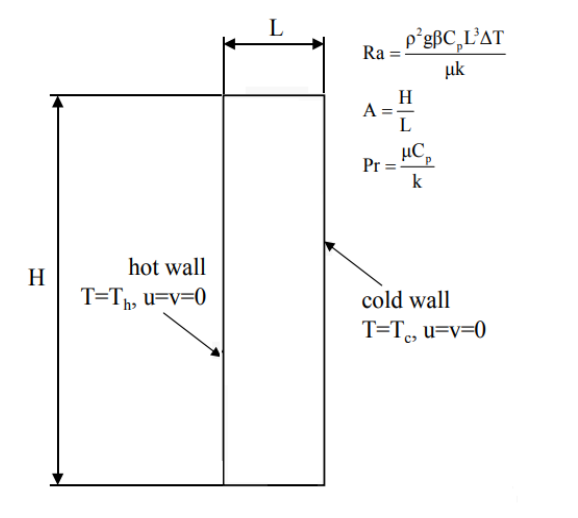
Fig. 1. Computational domain for two-dimensional formulation.